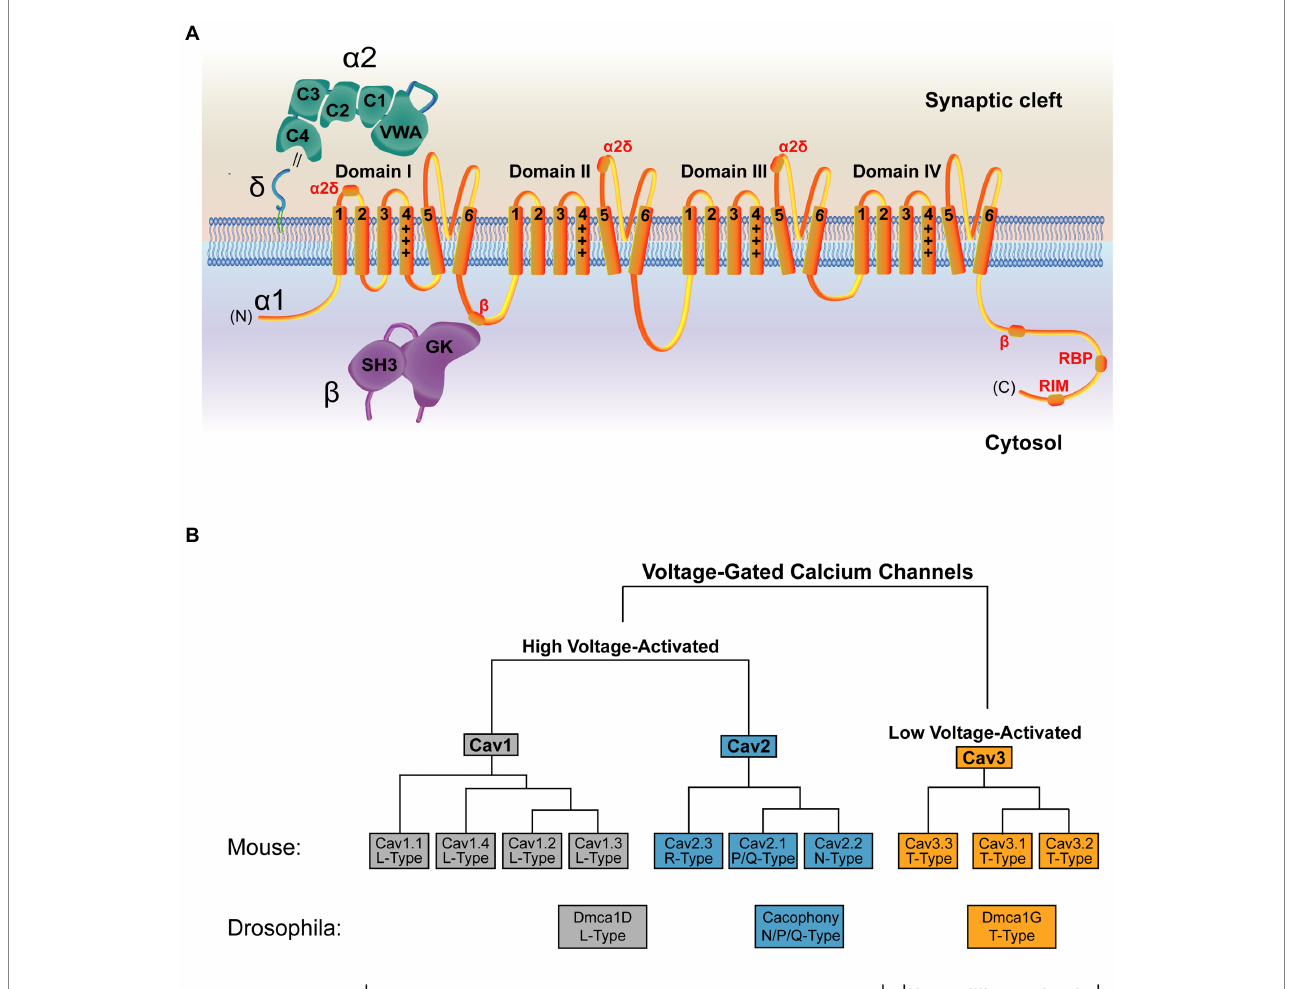
FIGURE 3 Structure and organization of the VGCC family. (A) Structure of a VGCC complex with the α 1 pore-forming subunit in orange. VGCCs have four domains with six transmembrane segments each. Transmembrane segments I-IV comprise the voltage-sensing module, with transmembrane segment IV (marked +++) as the voltage sensing segment. Transmembrane segments V and VI form the ion-conducting pore. The cytoplasmic C-terminal tail interacts with multiple binding partners, including a secondary Cavß interaction site (Walker et al., 1998) and binding regions for RBP and RIM (Lübbert et al., 2017). The α 2 δ subunit (green) is extracellular and comprised of α 2 and δ peptides linked via a disulfide bond (double black line) and anchored to the outer membrane leaflet via a lipid anchor (Davies et al., 2010; Wu et al., 2015). α 2 δ contains five domains, with the Von Willebrand Factor-A (VWA) and the first two Cache domains (C1 and C2) interacting with α 1 (Wu et al., 2016). Sites of α 2 δ -interaction on the α 1 subunit are marked in red. The Cavß subunit (purple) is cytosolic and comprised of an SH3 domain and a Guanylate Kinase (GK) domain. The primary α 1 interaction site is mediated through an intracellular loop in domain I of the channel and the Cavß GK domain (Pragnell et al., 1994; Cantí et al., 2001; Chen et al., 2004; Opatowsky et al., 2004; Van Petegem et al., 2004; Wu et al., 2016). (B) The mammalian VGCC family is comprised of 7 high voltage-activated VGCCs (Ca v 1 and Ca v 2 family channels) and 3 low voltage-activated VGCCs (Ca v 3 family channels). Drosophila (shown below the mammalian tree) encodes one VGCC per class, with Dmca1D encoding the sole L-Type Ca v 1 channel (Eberl et al., 1998; Hara et al., 2015), Cacophony (Cac) encoding the sole N/Q/P type Ca v 2 channel that mediates synaptic transmission